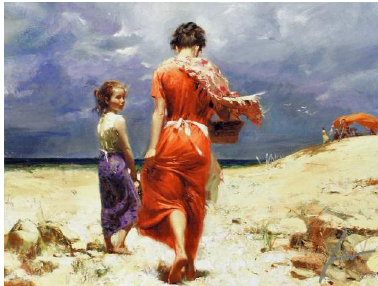
Figure 1. Pino Daeni: Summer